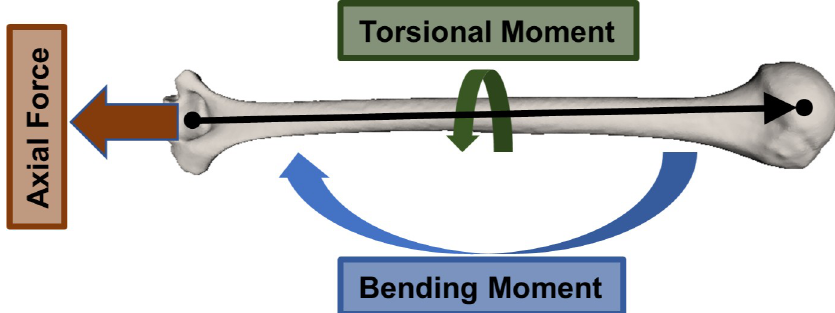
Fig 2. Schematic of the combined axial, bending and torsion loading modalities of the humerus. The humeral axis, as defined by the International Society of Biomechanics and in the AADL dataset, is the vector from the midpoint of the medial and lateral epicondyles pointing to the glenohumeral rotation center. Axial force is defined as the humeral reaction force projected onto the humeral axis vector; torsional moment, as the humeral reaction moment projected onto the humeral axis vector; and bending moment, as the humeral reaction moment projected onto the plane orthogonal to the humeral axis vector [19].